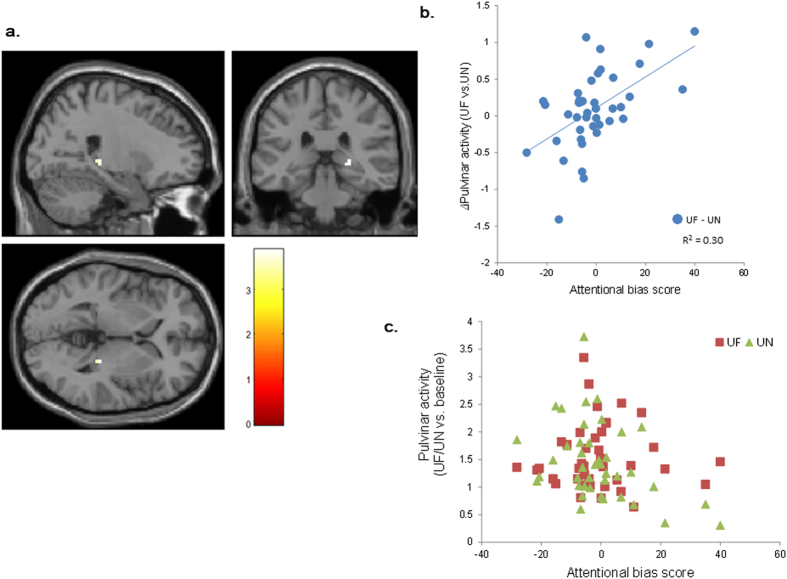
Increased activity in the right ml-pulvinar with greater attentional bias toward threat.(a) MNI coordinate: 24 −31 1. Colour bar indicates T-value. The figure is shown with the height threshold of p = 0.005 for illustration purposes. (b) Scatter plot of the relationship between attentional bias score and right ml-pulvinar activity in response to UF (vs. UN). (c) Scatter plot of the relationship between attentional bias score and right pulvinar activity in response to UF and UN. UF, unattended fearful faces condition; UN, unattended neutral faces condition; ml-pulvinar, a part of the medial and lateral pulvinar nuclei.